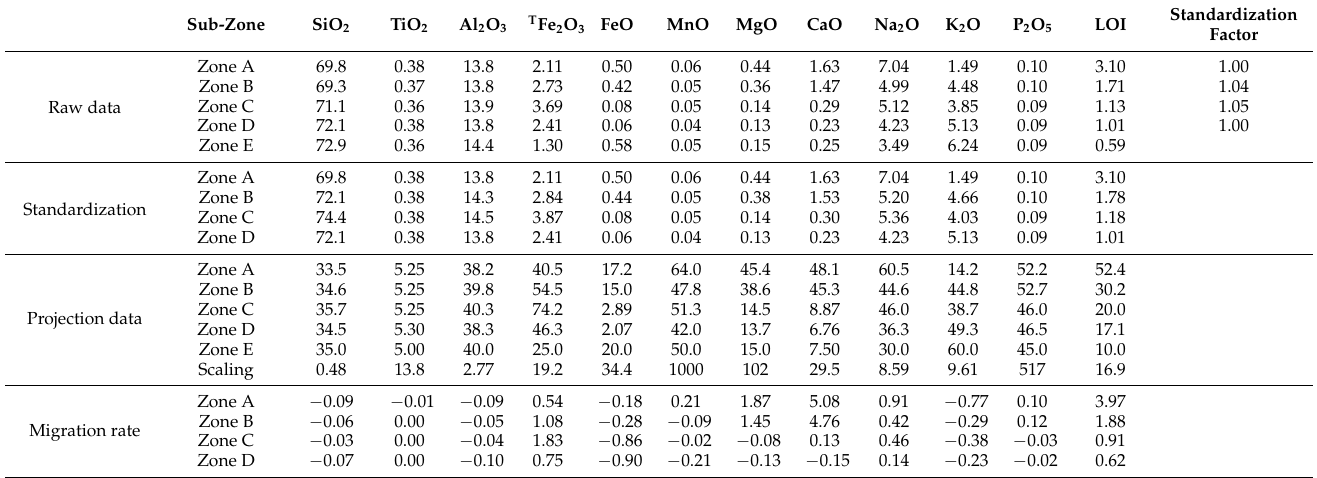
(Table 4): indicative values derived from relevant calculations. Table 1. Major element content (wt %) and data processing results of ore-fresh rock zoning rocks in the Zhangjiawu uranium deposit, Zhejiang Province,